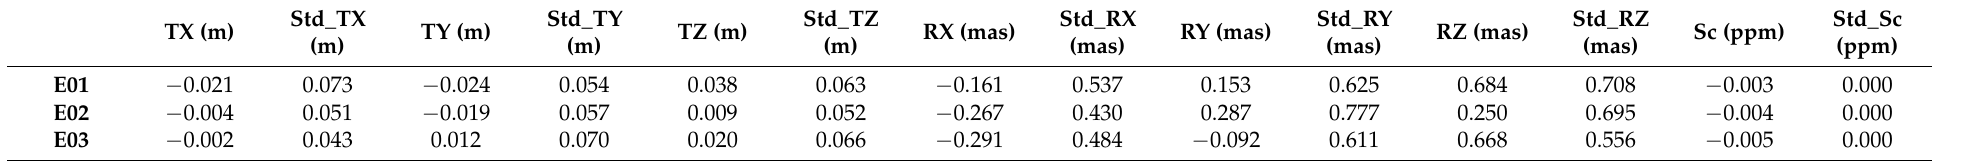
Table A3. Helmert parameters relating the Galileo reference frame to the ITRF2014 reference frame of the precise ephemeris of CNES. Average values for January